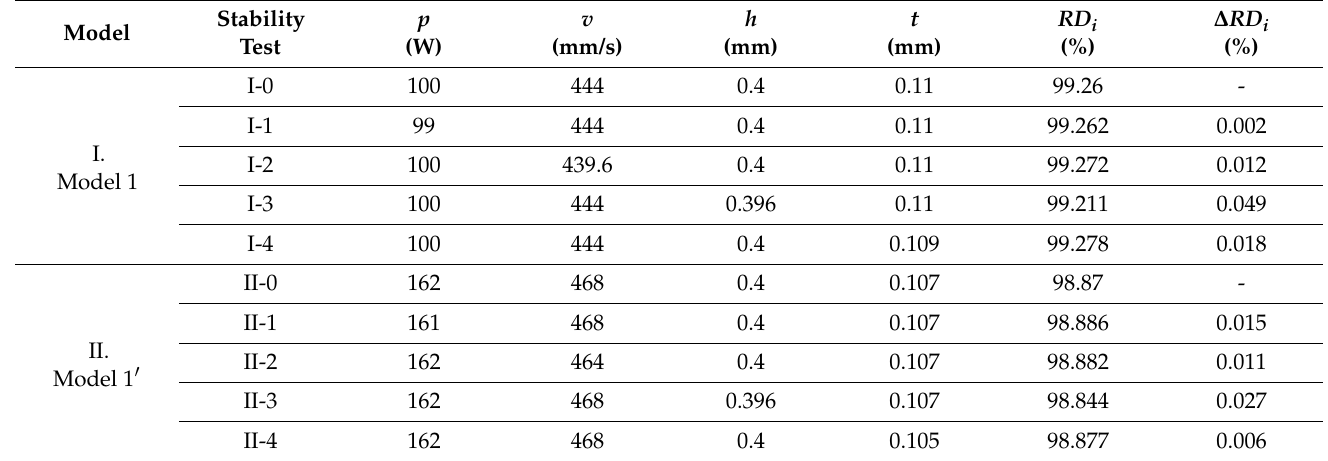
Table 6. Stability tests on the proposed solutions from Model 1 and Model 1 (cid:48)